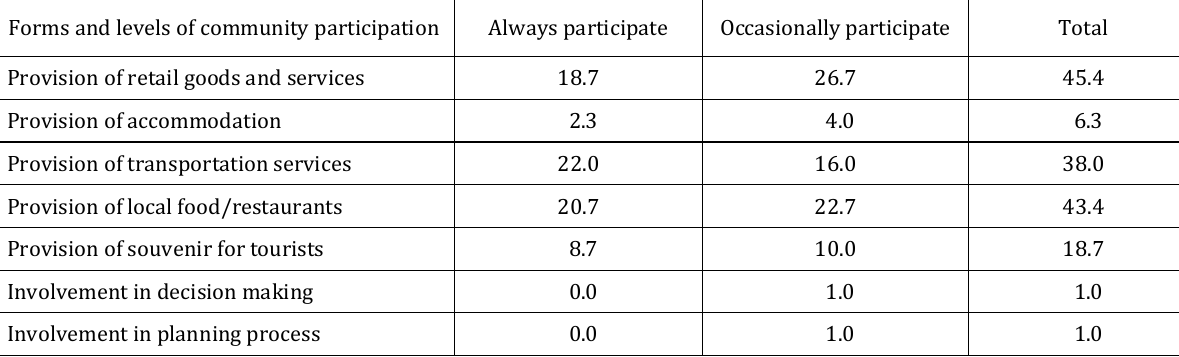
Table 4. Forms and levels of community participation in ecotourism (%) (n=150)